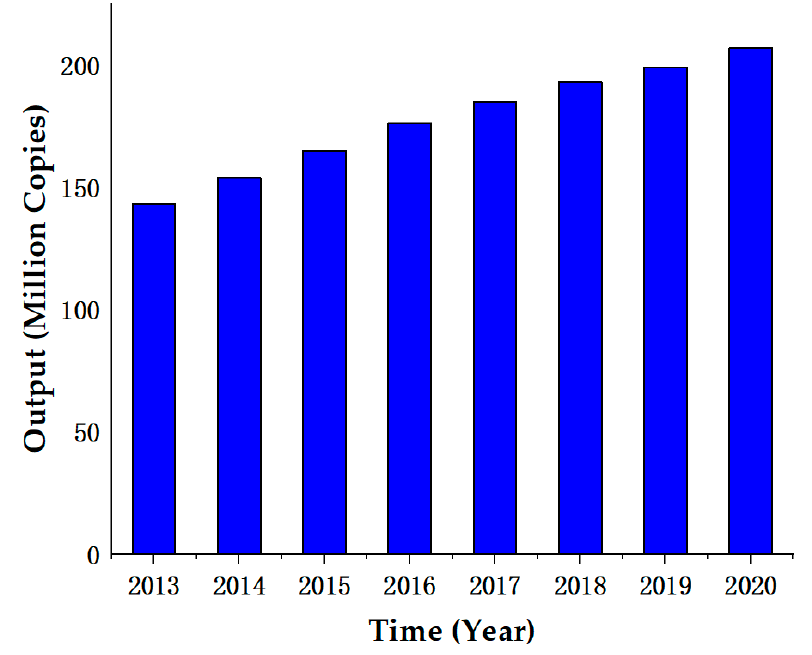
Figure 2. Statistical chart of global TFT-LCD demand in recent years.